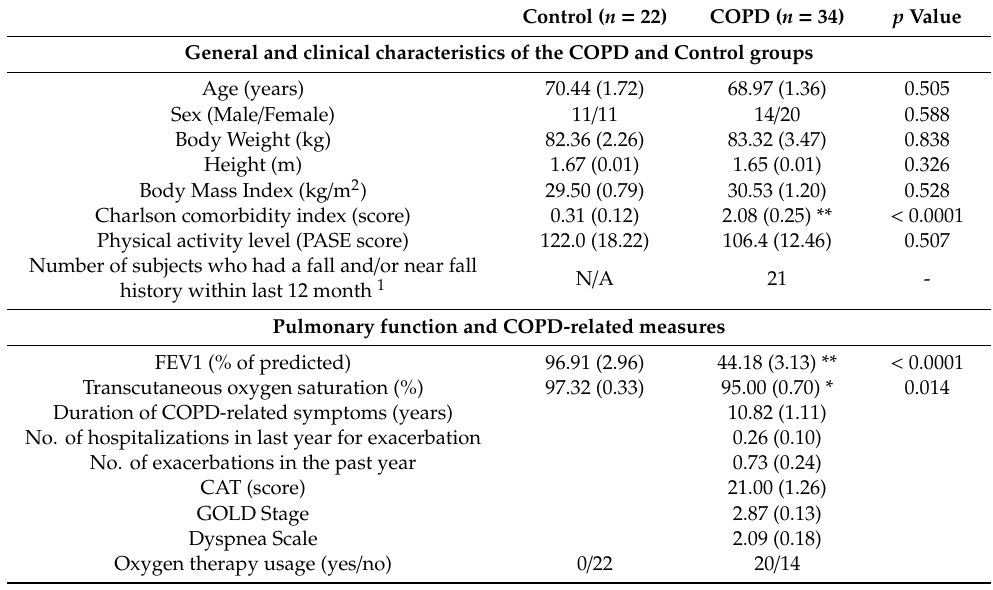
Table 1. Characteristics of the chronic obstructive pulmonary disease (COPD) and control